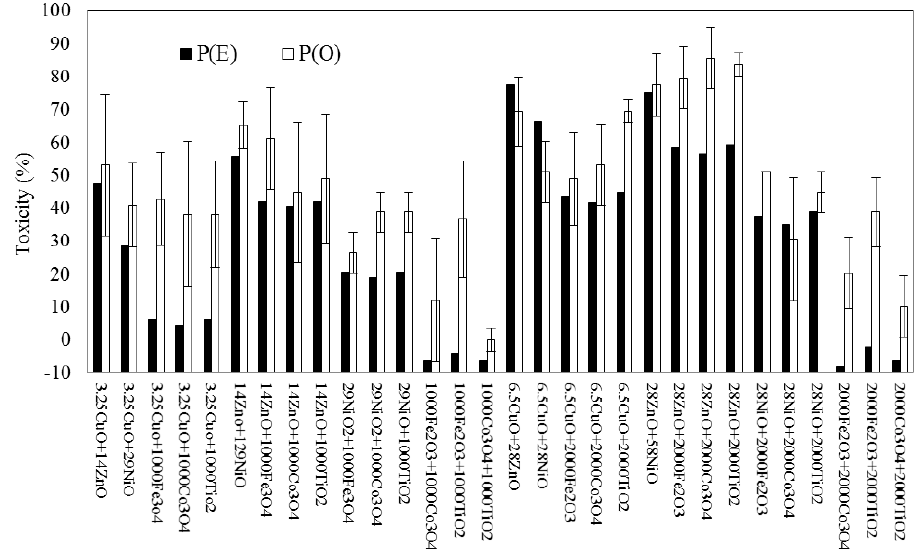
Figure 4. Comparison between theoretically expected and observed effects of binary NPs mixtures on the activity of seed germination showing synergistic and additive modes of action. P(E), the theoretically expected inhibition; P(O), the observed inhibition of the binary mixture. “14 ZnO + 1000 Co 3 O 4 ” means the binary mixture of 14 mg/L ZnO and 1000 mg/L Co 3 O 4 .